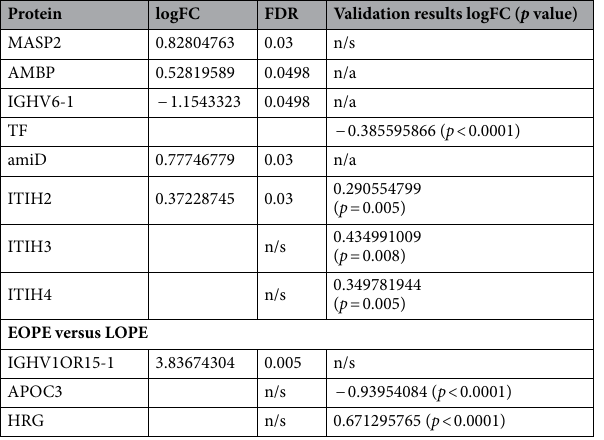
Table 3. DE plasma proteins of preeclampsia. n/a—not available. n/s—non-significant. AGT, angiotensinogen ; AMBP, protein AMBP ; amiD, N-acetylmuramoyl-L-alanine amidase ; AOC1, amiloride-sensitive amine oxidase [copper-containing] ; APOC3, apolipoprotein C-III ; APOC4-APOC2, APOC4-APOC2 readthrough (NMD candidate) ; APOE, apolipoprotein E ; A2M, alpha-2-macroglobulin ; B2M, beta-2-microglobulin ; CFD, complement factor D ; CPN2, carboxypeptidase N subunit 2 ; CST3, cystatin-C ; C1R, complement C1r subcomponent ; ENPP2, ectonucleotide pyrophosphatase/phosphodiesterase family member 2 ; FN1, fibronectin ; HGFA, hepatocyte growth factor activator ; HPX, hemopexin ; HRG, histidine-rich glycoprotein ; H2BC12L, Histone H2B type F-S ; H2BC14, histone H2B type 1-M ; IGFBP4, insulin-like growth factor- binding protein 4 ; IGHV1OR15-1, immunoglobulin heavy variable 1/OR15-1 (non-functional) (Fragment) ; IGHV6-1, immunoglobulin heavy variable 6–1 ; IGLV3-21, immunoglobulin lambda variable 3–21 ; IGKV1-9,